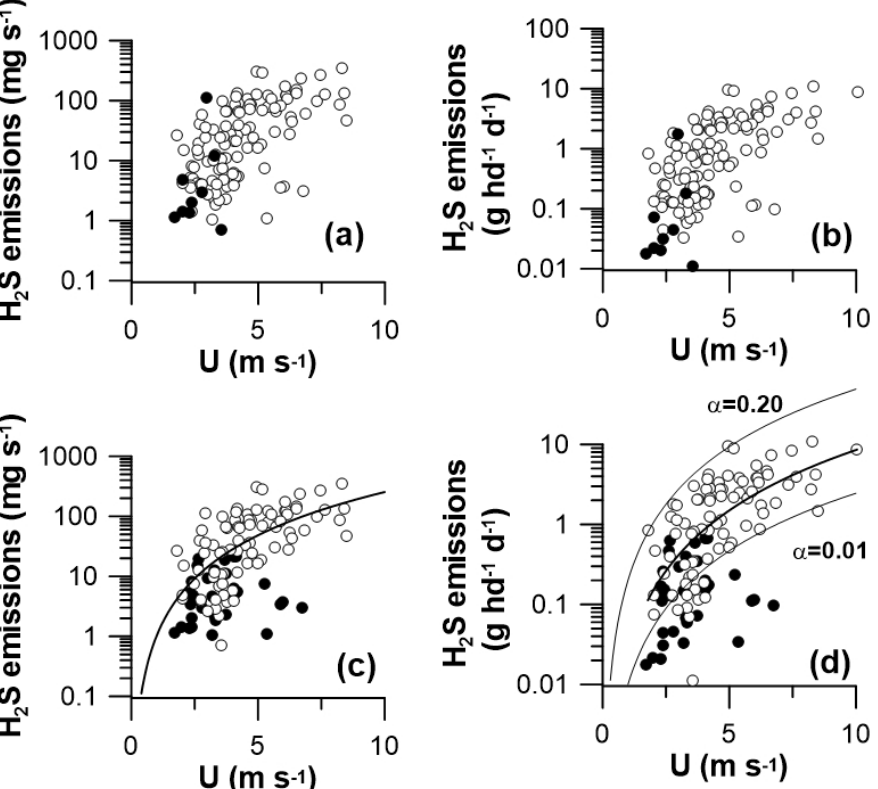
Figure 8. Dependence of daily H 2 S emissions (representative days) on wind speed. The daily mean emissions for the NC (filled circle) and OK (open circle) are indicated relative to farm lagoon ( a ) and farm head of animals loading the lagoon ( b ). The daily mean animal-based emissions for the lagoon with evident PSB (filled circle) and not evident PSB (open circle) are indicated relative to farm lagoon ( c ) and farm head of animals loading the lagoon ( d ). The power function regressions of emissions on wind speed (Equation (1)) are indicated by solid line with the upper and lower bound of the power function for the non-PSB lagoon emissions indicated by the thin lines respectively.